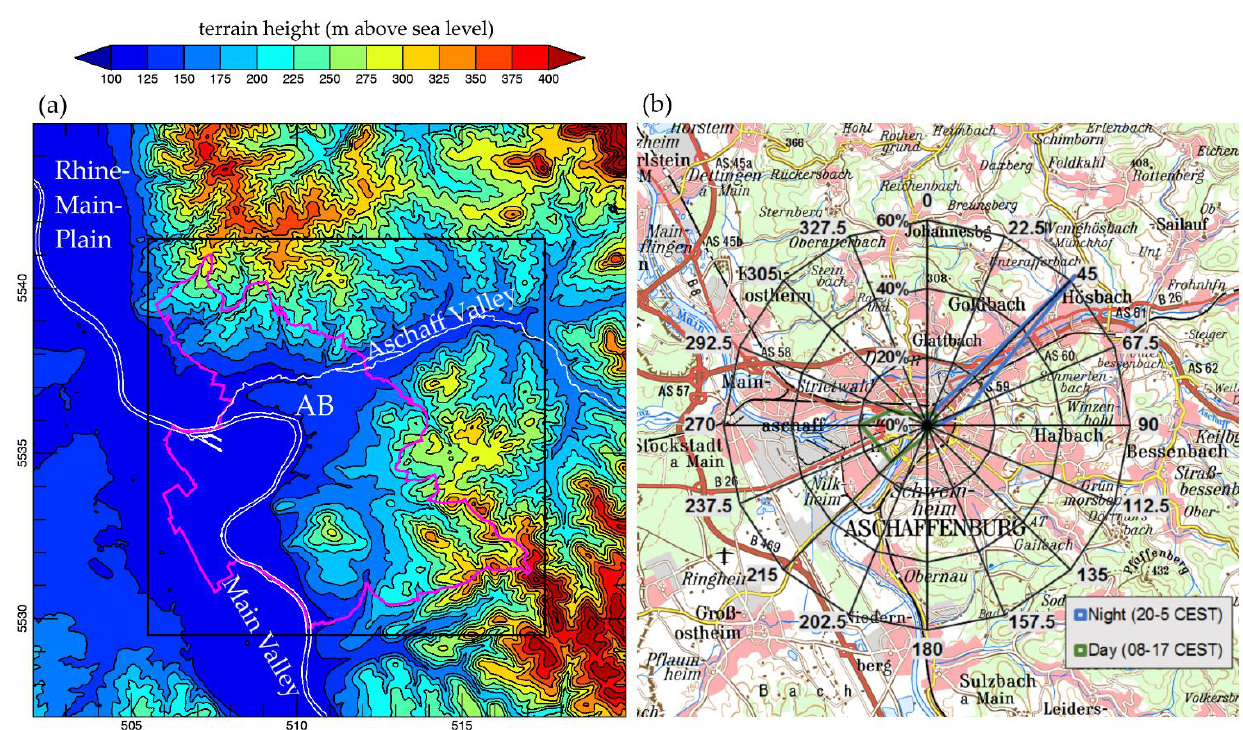
Figure 2. ( a ) Map of the terrain elevation in m asl in the 18 km × 18 km equidistant grid core area of the model domain. The 12 km × 12 km modelling subdomain for the presentation of results (black square), the city border (magenta contour), the city center (AB) of Aschaffenburg and the rivers Main and Aschaff (white contour) are also shown. ( b ) Topographic map of the 18 km × 18 km domain (reprinted with permission from [43]. 2009, GeoBasis-DE/BKG) with the wind rose observed under synoptically calm and fair weather conditions in the warm seasons (April–September), measured during the period of 2018–2020 on top of a high building in Aschaffenburg